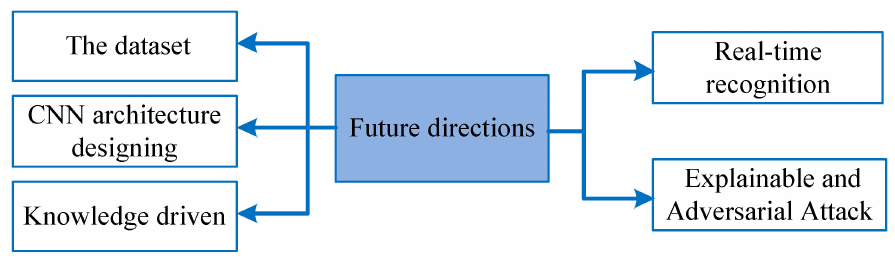
Figure 27. The future